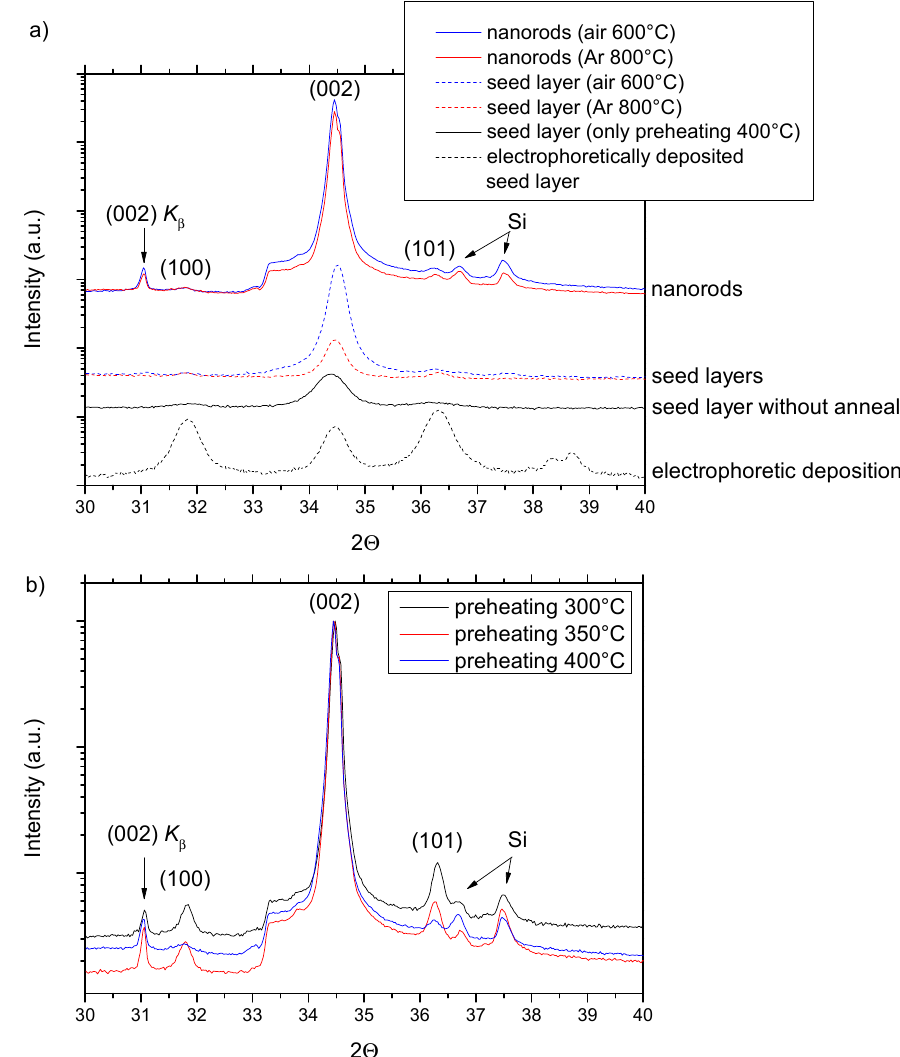
Figure 4. ( a ) X-ray di ff raction patterns of the seed layers (dashed lines) preheated at 400 ◦ C and annealed either in air at 600 ◦ C or in Ar at 800 ◦ C. Corresponding data for the ZnO nanorods (solid lines) grown on these seed layers. In addition, a comparison is shown with the seed layer preheated at 400 ◦ C without any annealing (black solid line) and with a seed layer prepared by electrophoretic deposition (black dashed line). Besides the (100), (002), and (101) peaks corresponding to ZnO, the silicon substrate peaks and the (002) K β reflection are visible in the patterns. ( b ) XRD patterns of the seed layers preheated at di ff erent temperatures and annealed in Ar at 800 ◦ C. The peak intensities were normalized to (002) reflection.